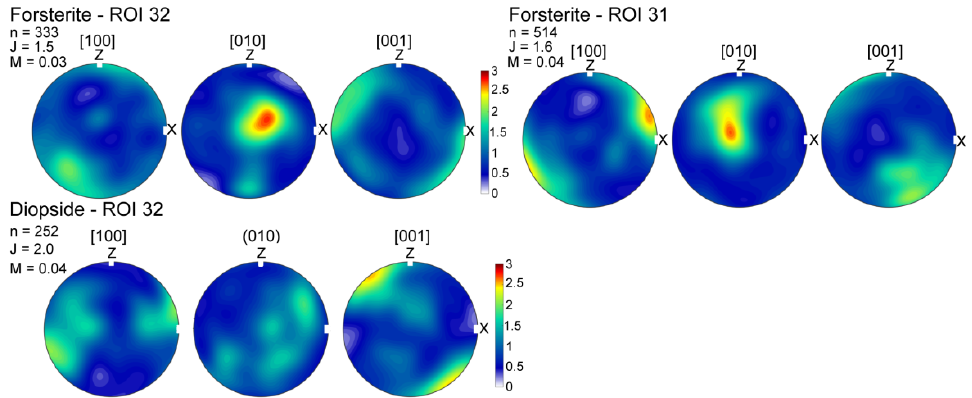
Figure 8. Forsterite and diopside CPO of the matrix displayed in Figure 6c (ROI32) and of the olivine matrix (ROI31).